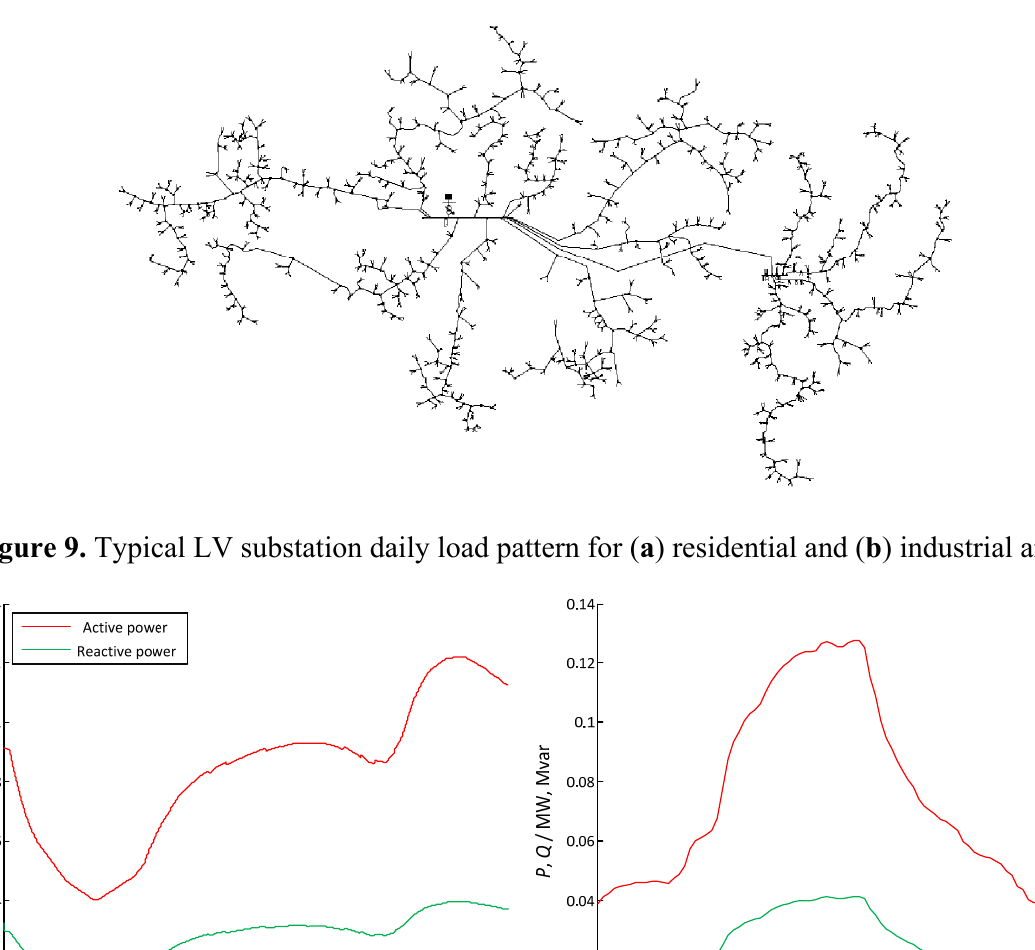
Figure 8. Large medium-voltage distribution system under study.